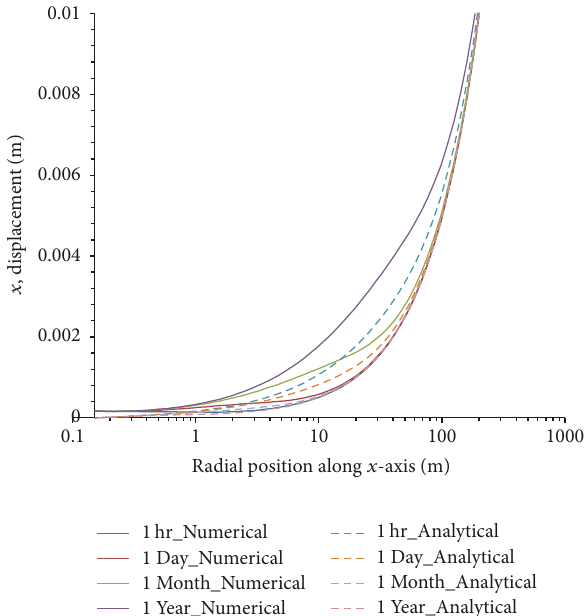
Figure 6: 𝑋 -component of tangential stresses as a function of time in poroelastic medium with 𝜎 𝐻 = 5800 psi and 𝜎 ℎ = 5500 psi, 𝑃 𝑟 = 5500 psi, 𝑃 𝑤 = 1000psi, 𝑘 𝑥 = 0.01md, and 𝑘 𝑦 =